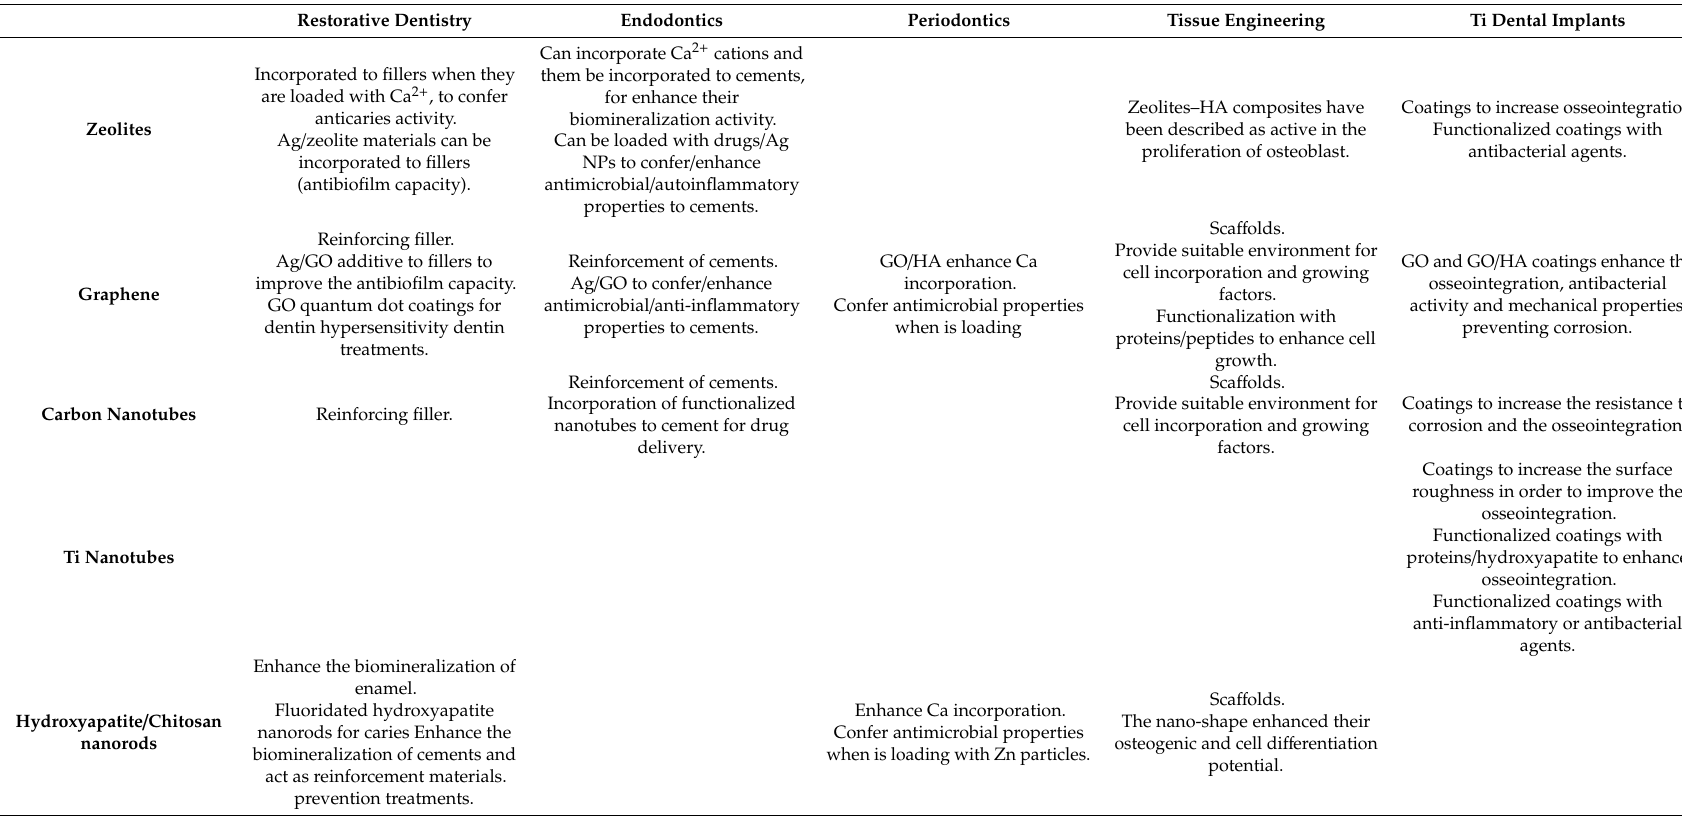
Table 2. Most important applications developed in dentistry with the use of nanomaterials. GO (Graphene Oxide), NPs (NanoParticles), HA